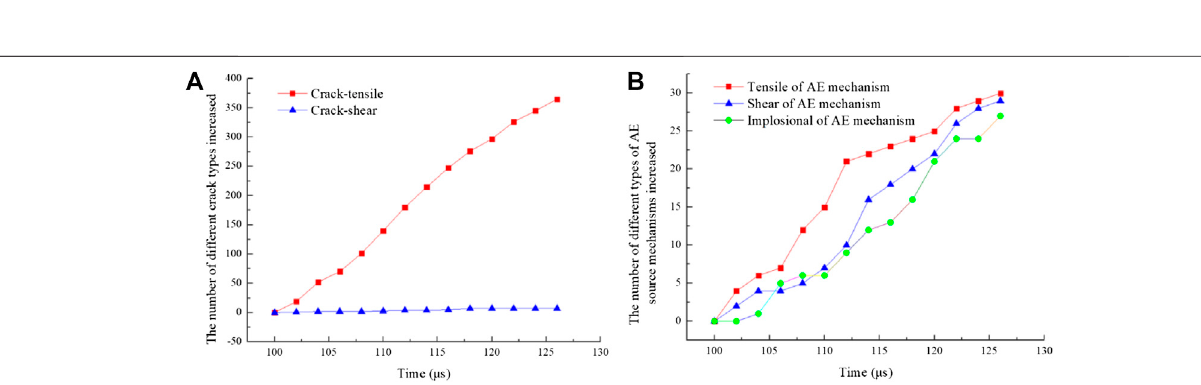
Figure 13 is the statistical results of Figure 12 . Figure 13A is the number of different crack types increased from 148 to 173 μ s obtained by PFC simulation. The tensile micro-cracks continued to increase from 148 to 161 µs. Then it stays stable from 161 to